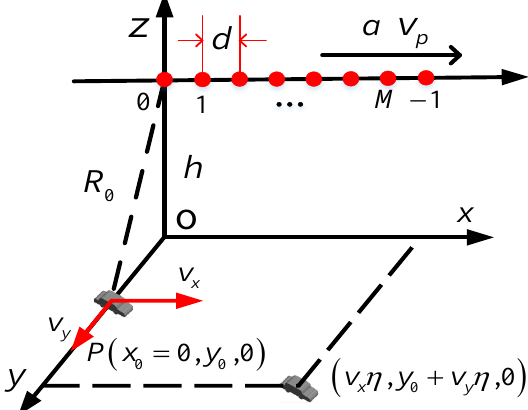
Figure 1. The geometry model of multichannel maneuvering